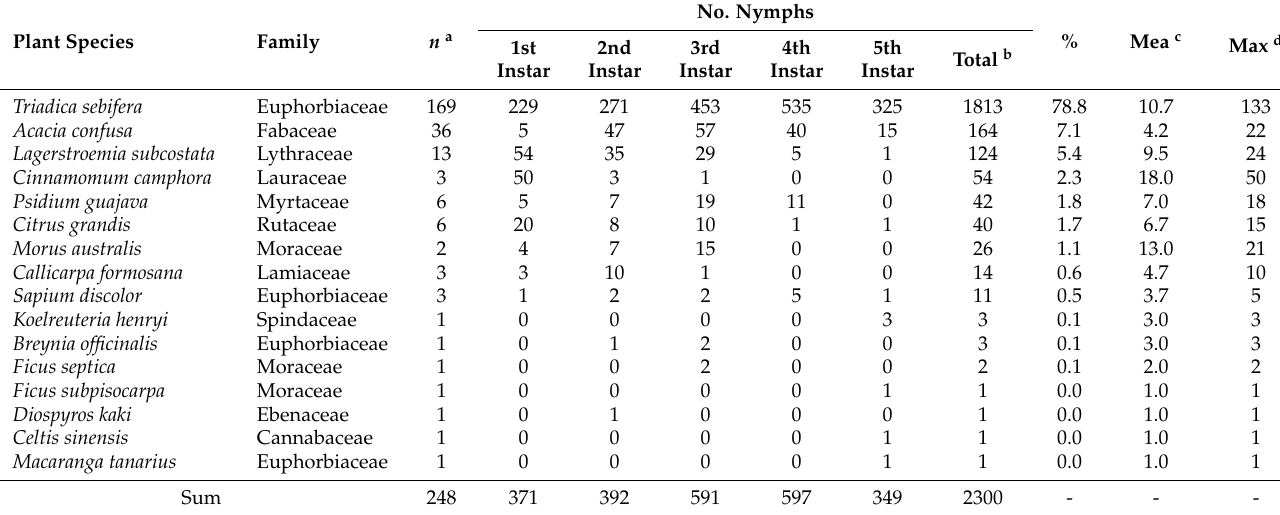
Table 3. Numbers of nymphs of Pyrops candelaria recorded on different plant species from 20 May–20 July 2021.